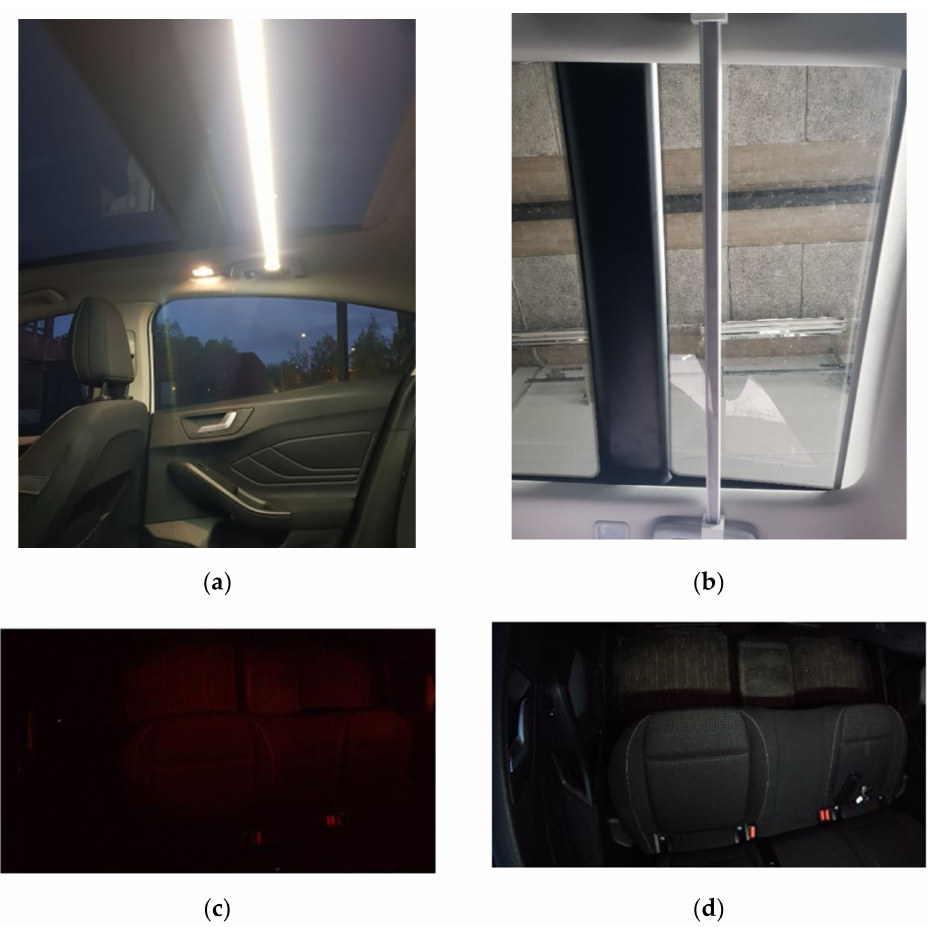
Figure 4. Comparison of using the LED strip to obtain images of clarity. ( a ) LED strip when illuminated. ( b ) LED strip when non-illuminated. ( c ) Image captured without illuminating the LED strip when it is dark outside. ( d ) Image captured while illuminating the LED strip when it is dark